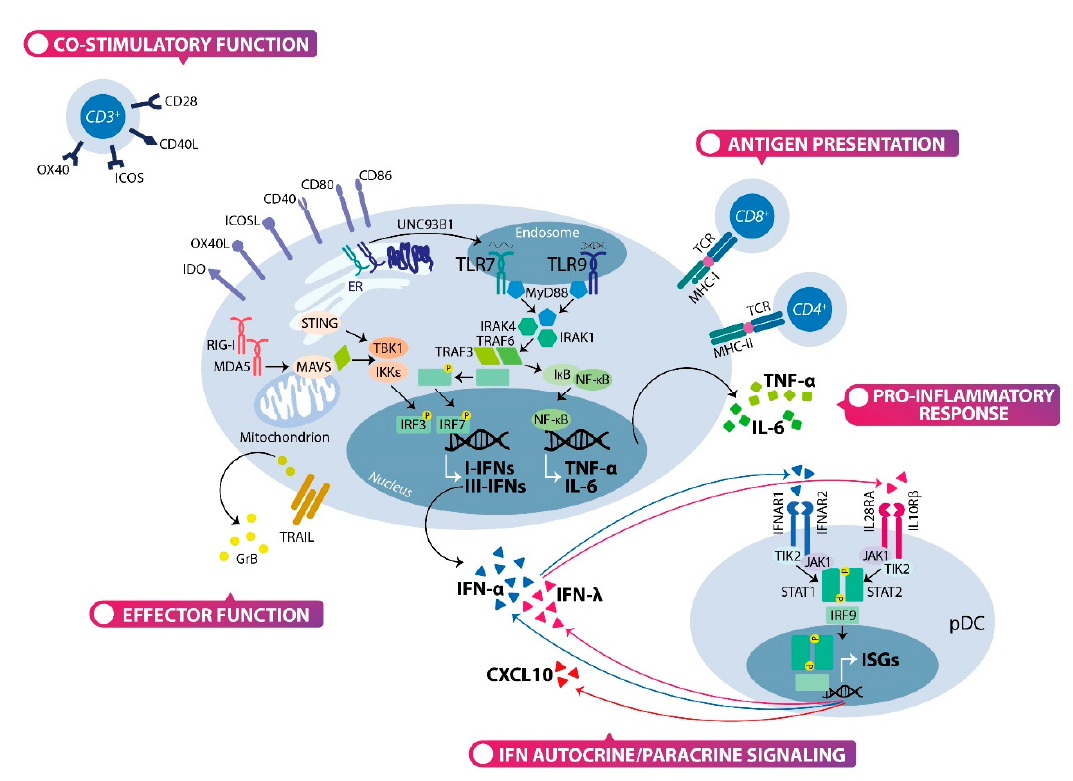
Figure 2. The multifaceted function of human pDCs. Graphical illustration of the human pDC functions. Human pDCs play a role in defense against pathogens, in autoimmunity and in cancer. pDCs perform these functions by modulating type I interferon and pro-inflammatory cytokines availability, by presenting antigens to T-cells, and by activating T-cells and exerting direct effector functions. Surface molecules and intracellular mechanisms involved are detailed.